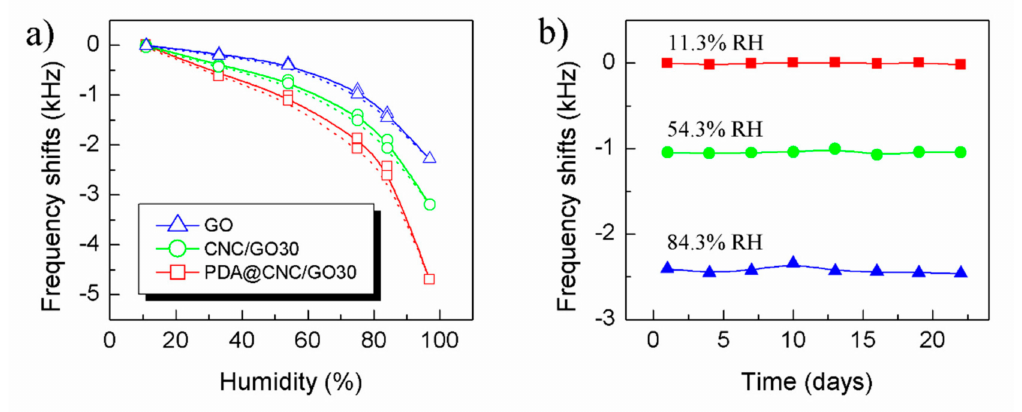
Figure 8. ( a ) Humidity hysteresis; and ( b ) long-term stability of PDA@CNC / GO30 nanocomposite-coated QCM humidity